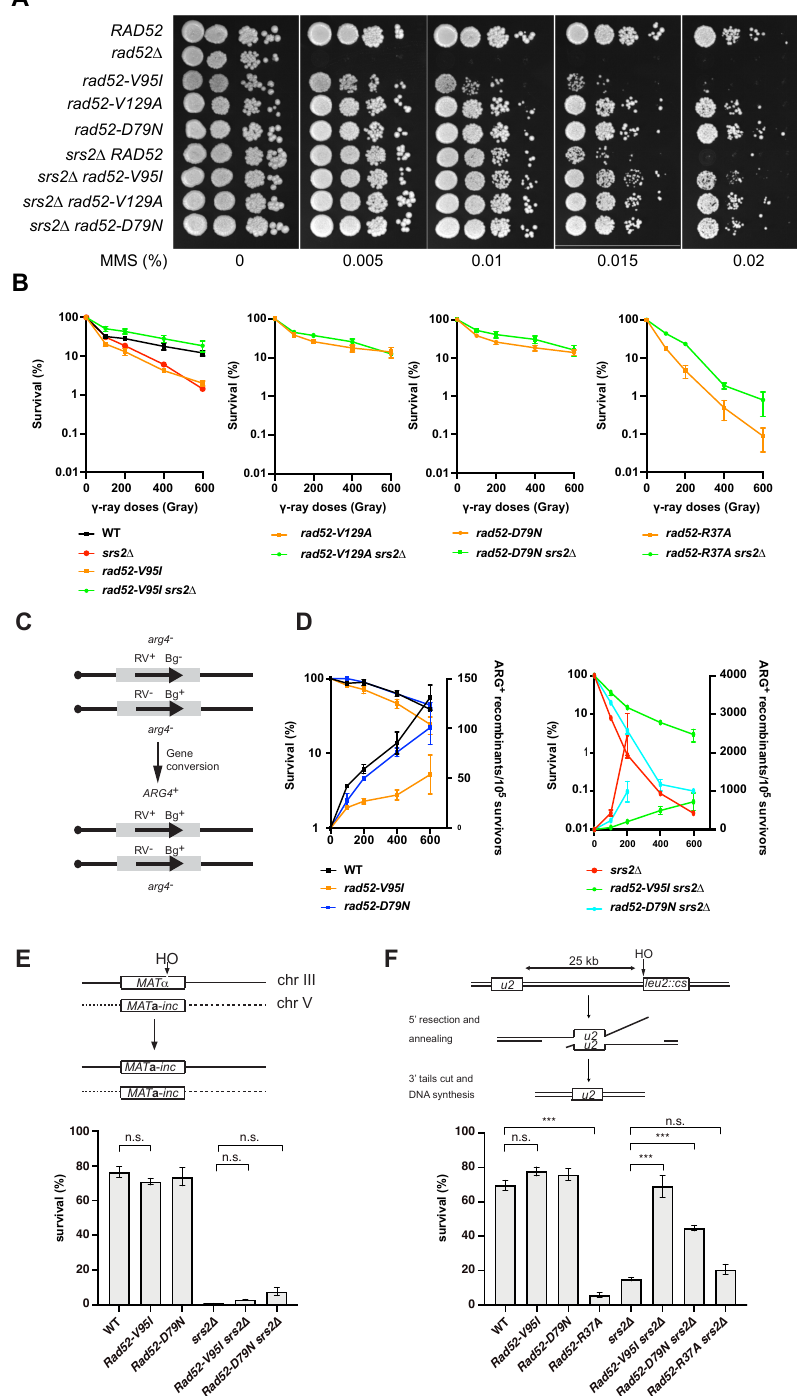
Figure 1. Mutations in the conserved N-terminal domain of Rad52 suppress MMS and γ -Ray sensitivity in Srs2-deficient cells. ( A ) Serial 10-fold dilutions of haploid strains with the indicated genotypes